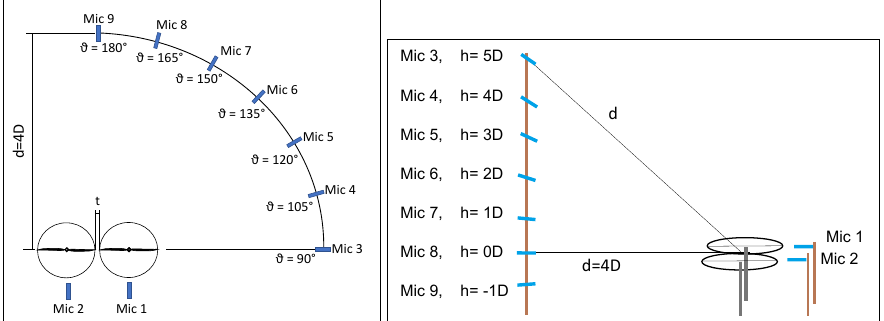
Figure 1. Experimental set-up of the acoustics measurements. Top view of the azimuthal array, which characterizes the azimuthal directivity ( left ). The linear array was set up to characterize the polar directivity ( right ).